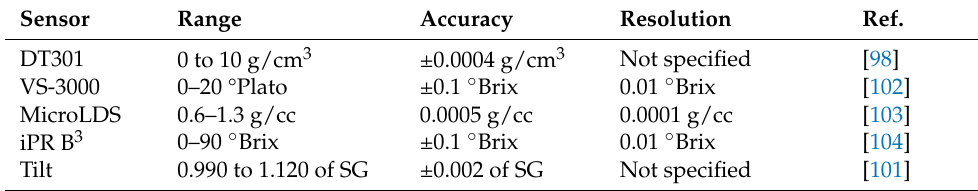
Table 9. Specifications of in-line Brix